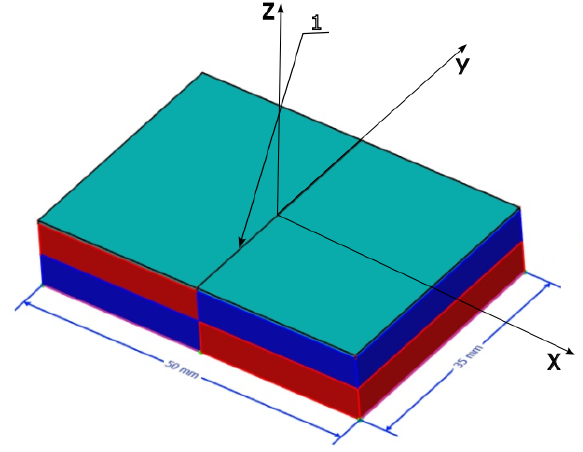
Figure 3. Two permanent magnets generate a gradient magnetic field. The magnetic gradient reaches its maximum just above the contact surface (1).